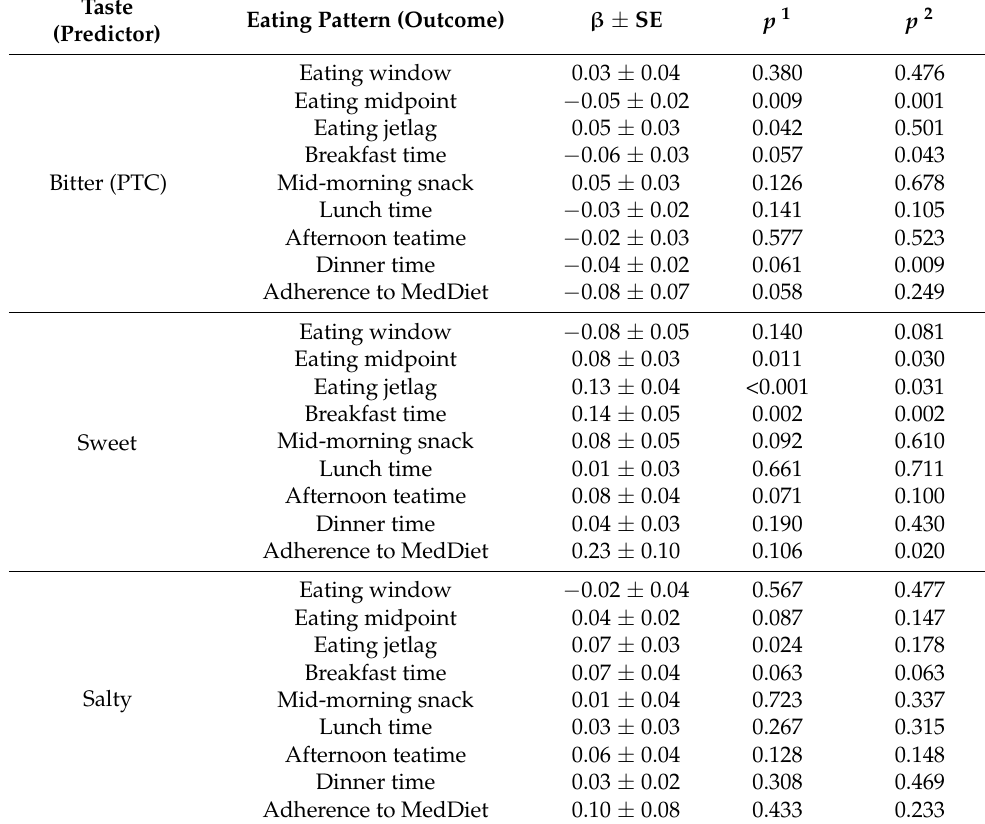
Table 4. Associations between measured taste perception and eating